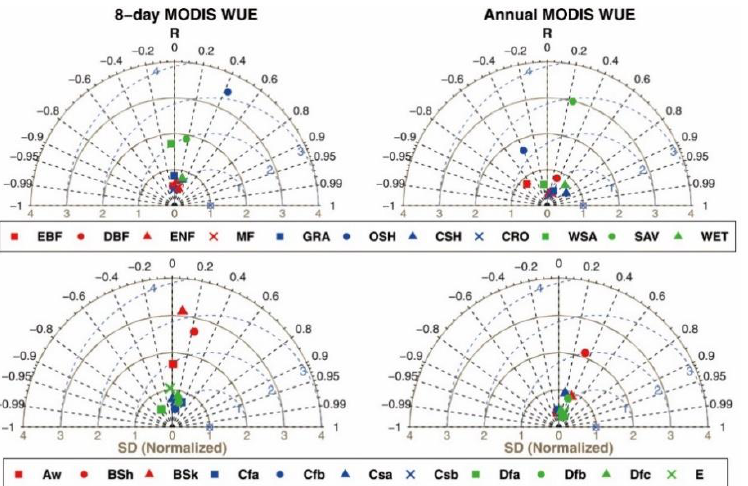
Figure 5. Taylor diagrams of MODIS WUE compared to flux measurement for 11 plant functional types and climate zones at 8-day and annual time scales [86]. Reprinted with permission. Adapted with permission from ref. [86]. Copyright 2020 Elsevier.